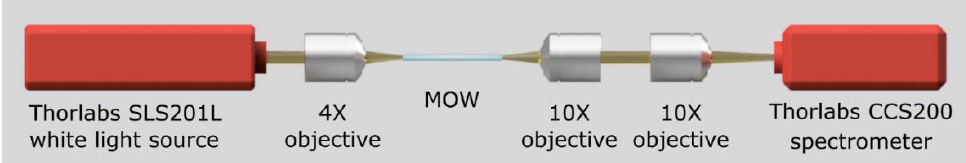
Figure 3. Schematics of the transmission measurement setup.